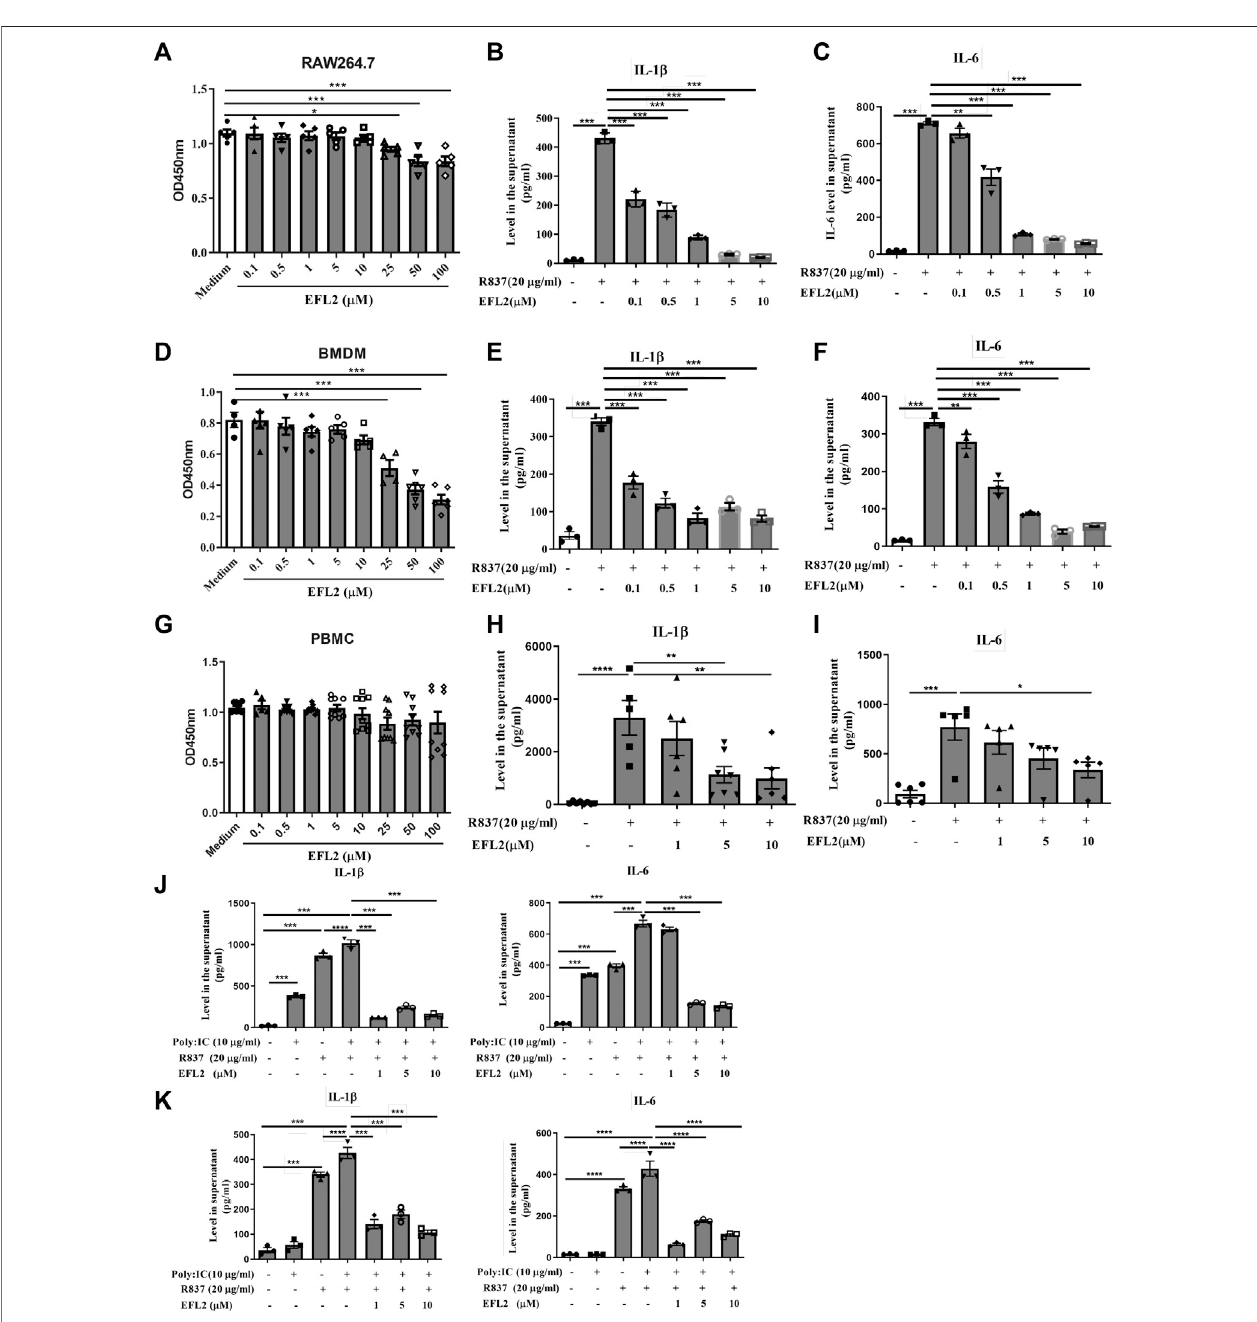
FIGURE4| EuphorbiafactorL2reducesIL-1 β andIL-6productioninR837-stimulatedmacrophagesinvitro (A,D,G) Cytotoxicityeffectofdifferentconcentrations of EFL2 (0.1, 0.5, 1, 5, 10, 25, 50 and 100 μ M) on RAW264.7 cell (A) bone marrow-derived macrophages (BMDMs) (D) or PBMCs (B, E, H) Effect of different concentrationsofEFL2(0.1,0.5,1,5,10 μ M)onIL-1 β productioninR837-stimulatedRAW264.7,BMDMsandPBMCs (C,F,I) EffectofdifferentconcentrationsofEFL2 onIL-6productioninR837-stimulatedRAW264.7,BMDMsandPBMCs (J,K) TheinhibitoryeffectofEFL2onIL-1 β andIL-6secretedbyRAW264.7 (J) orBMDMs (K) under the co-stimulation of poly:IC and R837. n (cid:1) 3 for each group in an independent experiment. Data represent the mean values ± SEM of three independent experiments. * p < 0.05, ** p < 0.01, *** p < 0.001 were considered statistically signi fi cant.